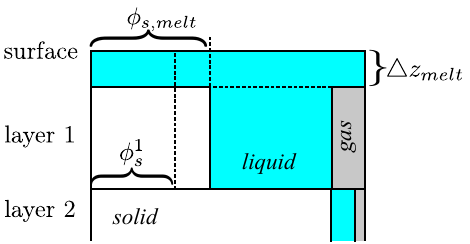
Figure 4. Formation of meltwater in the top ice layer when φ 1 s < φ s , melt as described in Sect. 2.3.2. The thickness of the layer of meltwater ( (cid:52) z melt ) is determined by how much the solid fraction has to be raised to equal φ s , melt . The white, blue, and grey areas represent the solid, liquid, and gas volume fractions of each model